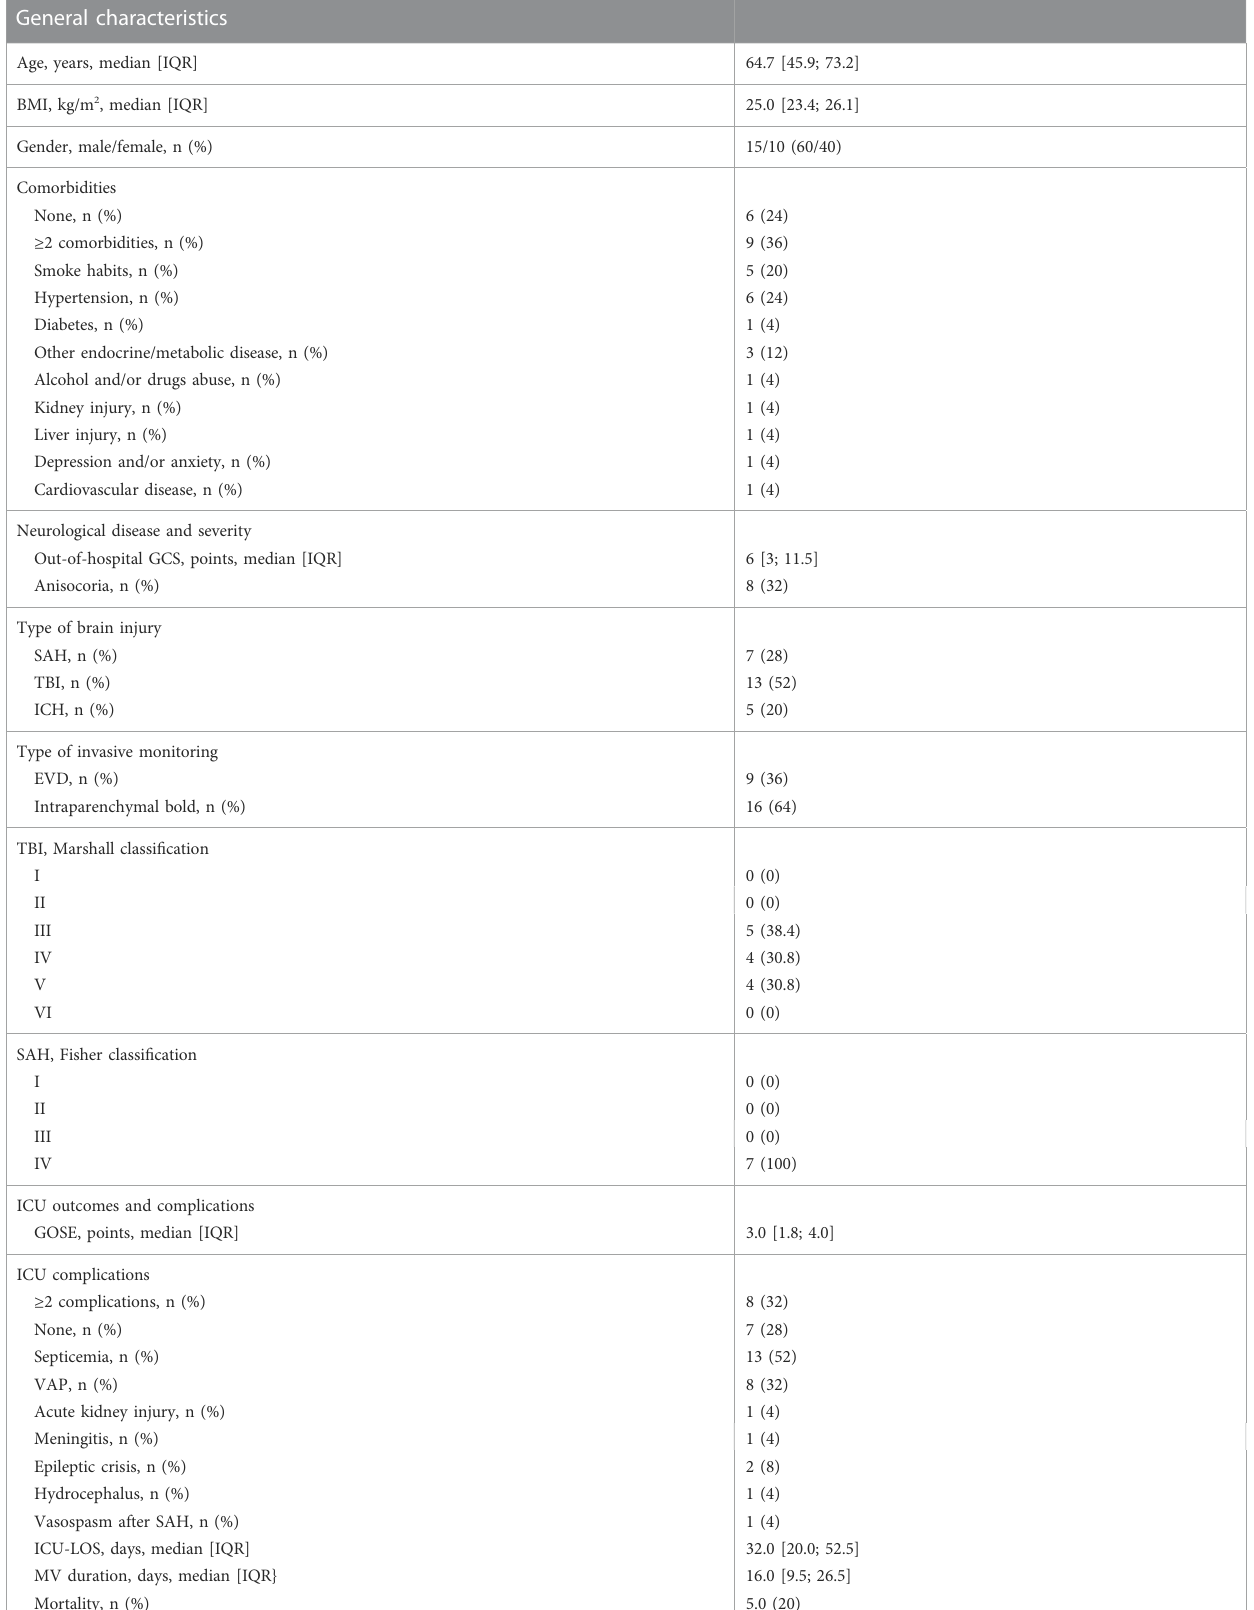
TABLE 1 Patients demographics, characteristics, intensive care unit (ICU) complications and patient outcomes. General